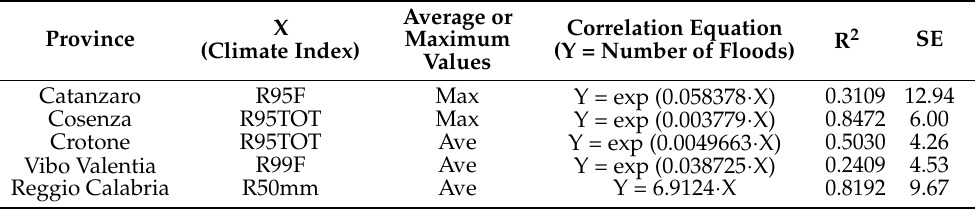
Table 5. The best fitting models between the climate indices (for average or maximum values) and the annual number of floods occurred in each province of Calabria.